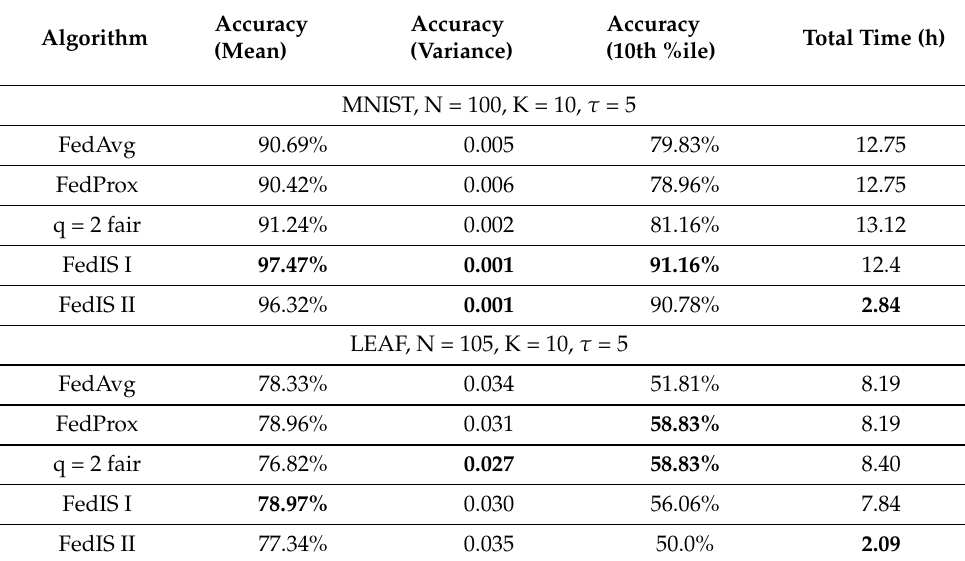
Table 2. Performance evaluation of federated learning with importance sampling